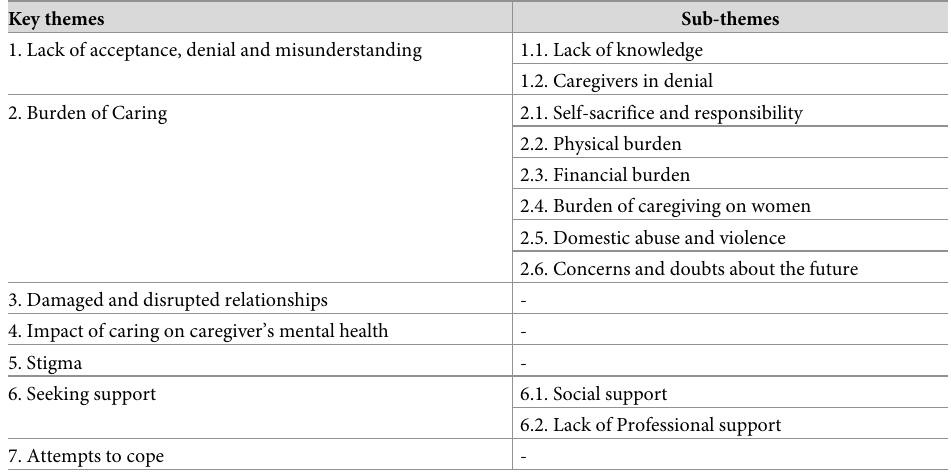
Table 3. Overarching themes emerging from